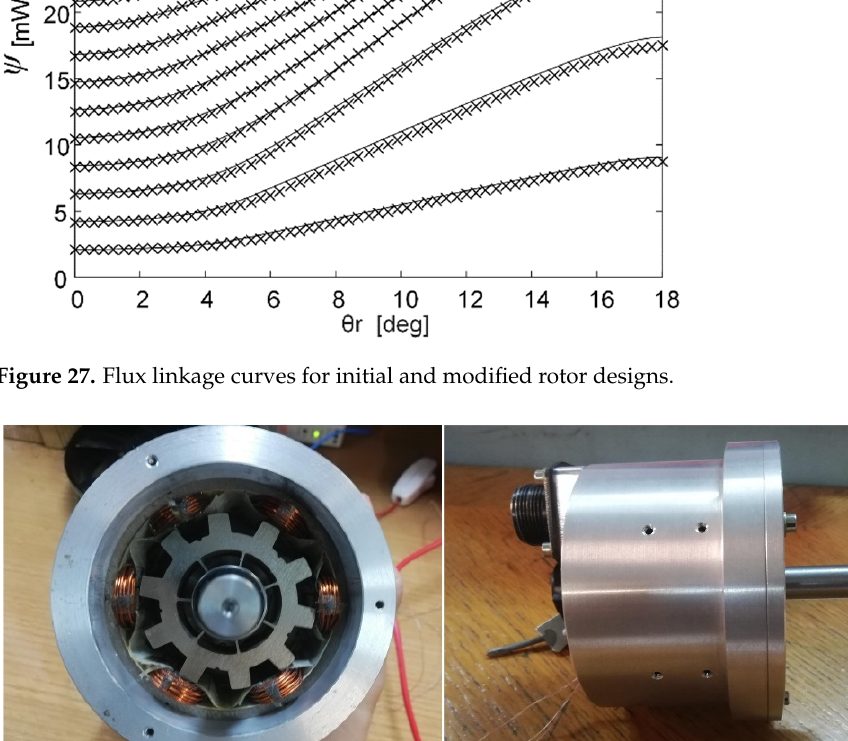
Figure 28. Manufactured prototype. Stator with the windings and rotor are shown on the ( left ), and complete motor with the housing on the ( right ) side. complete motor with the housing on the ( right )